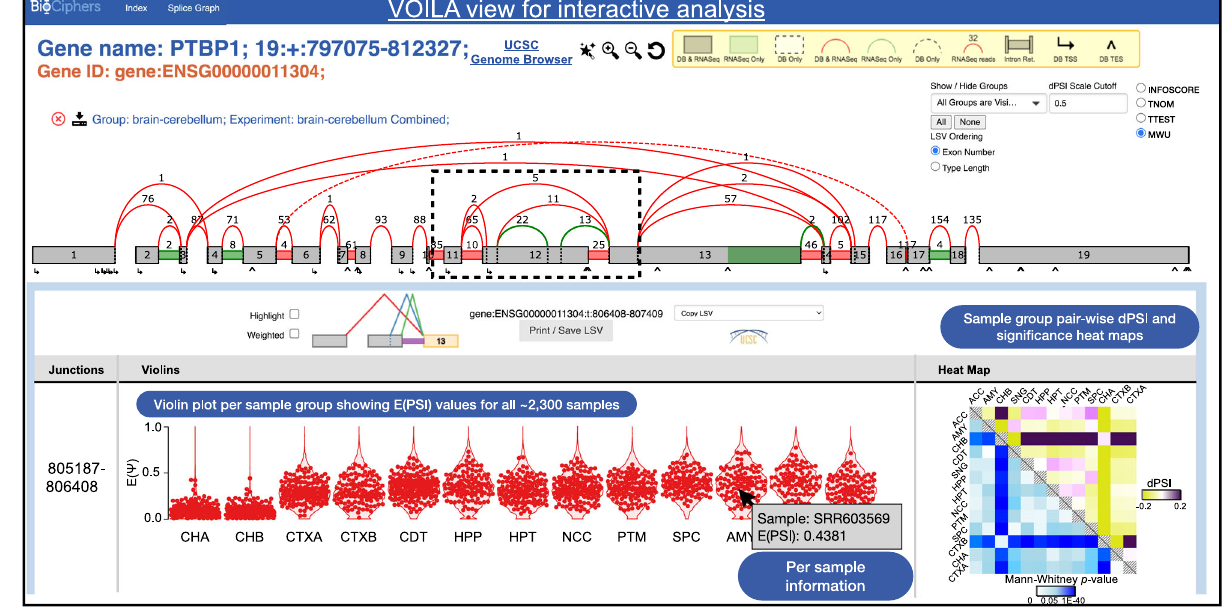
Fig. 3 | Enhanced visualization of large datasets with VOILA v2. VOILA view of MAJIQ HET output for 13 brain tissue groups from GTEx from 2335 RNA-seq sam- plesoriginatingfrom374uniquedonors.Topportionshowsgeneinformationand fi ltering criteria as well as the splicegraph for PTBP1 showing median read counts from 225 cerebellum samples. Bottom portion displays visualization and PSI quanti fi cation for each junction in each LSV for the gene of interest. Here the distributionof E Ψ ½ (cid:2) valuesacrosstheindicated tissuegroups(abbreviationsgiven inFig.5a)isdisplayedasaviolinbeeswarmplotfortheredjunctionfortheexon13 target LSV, represented in the cartoon, for all 2335 RNA-seq samples. Individual